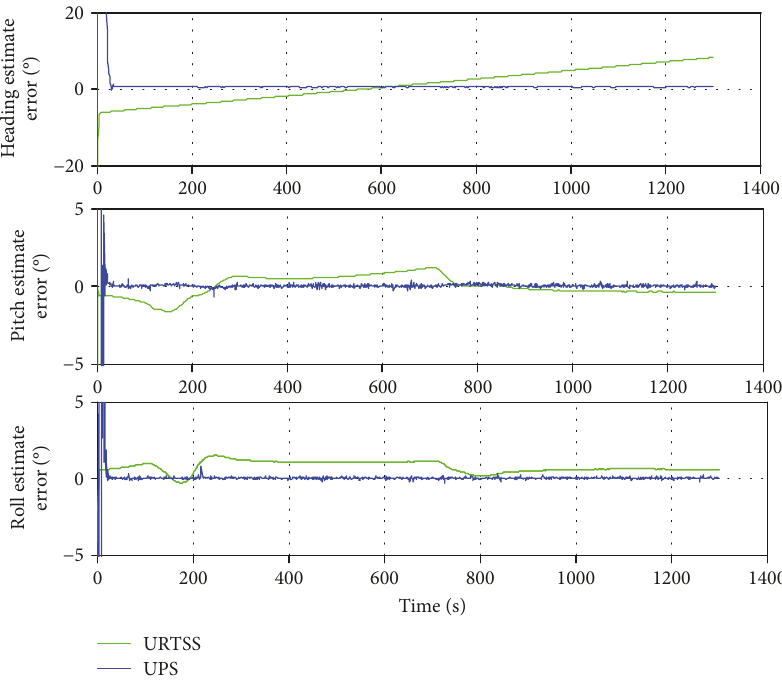
Figure 7: Attitude estimate errors of UPS and